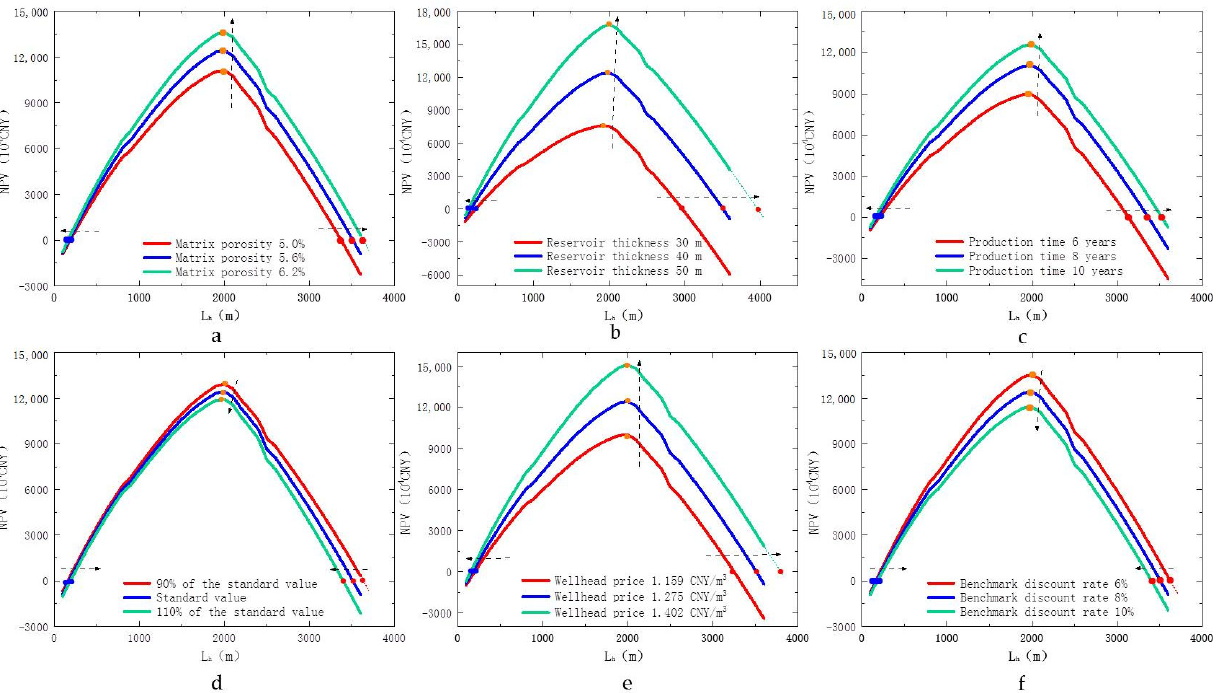
Figure 6. Relationship curves between the NPV and lateral length of a shale-gas horizontal well with six changing factors. ( a ) the relationship curve between the NPV and lateral length with different matrix porosities; ( b ) relationship curve between the NPV and lateral length with different reservoir thicknesses; ( c ) relationship curve between the NPV and lateral length with different production time; ( d ) relationship curve between the NPV and lateral length with different drilling investment values; ( e ) relationship curve between the NPV and lateral length with different wellhead prices; and ( f ) relationship curve between the NPV and lateral length with different benchmark discount rates.